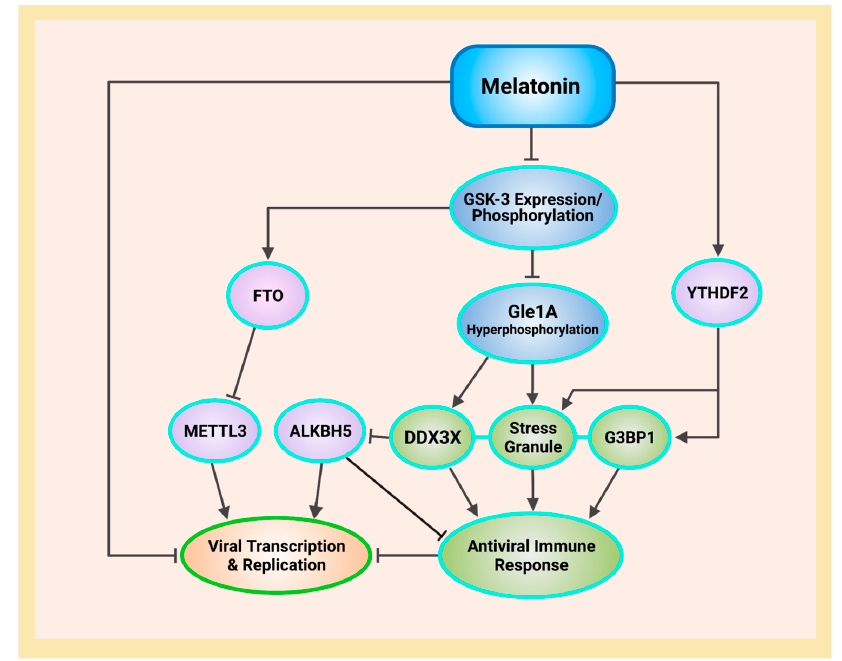
Figure 2. Overview of antioxidant-dependent and -independent mechanisms used by melatonin to regulate m 6 A modifications during SARS-CoV-2 infection and PASC. Melatonin increases the m 6 A “reader” YTHDF2, allowing the proper nucleation of stress granules by G3BP1 to promote antiviral immune response. Melatonin inhibits GSK-3 gene expression and phosphorylation to suppress Gle1A hyperphosphorylation that allows DEAD-box RNA helicase DDX3X to interact with ALKBH5 and stress granules to enhance immune response that reduces viral transcription and replication. The suppression of GSK-3 increases the m 6 A demethylase FTO that “erases” modifications by m 6 A methyltransferase METTL3, decreasing m 6 A levels to suppress viral replication (see Abbreviations for additional acronyms).